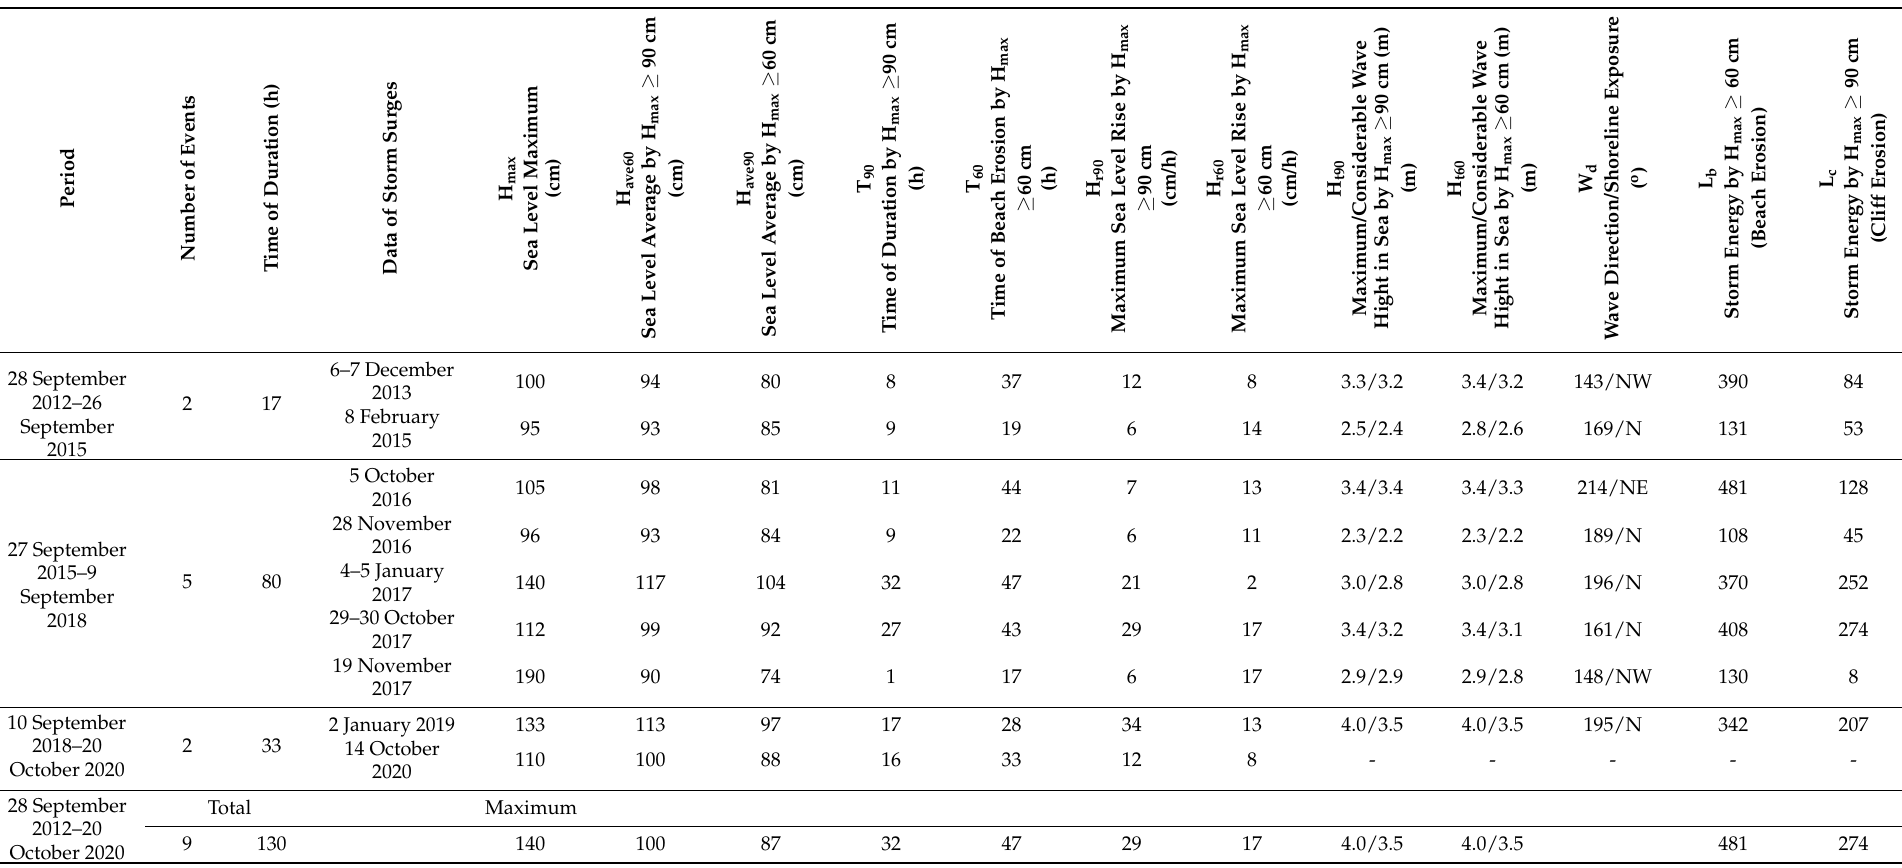
Table 5. Parameters of hydrodynamic properties (´Swinouj´scie—N.N. reference level). Raw data source—Institute of Meteorology and Water Management, Interdisciplinary Modeling Center of the University of